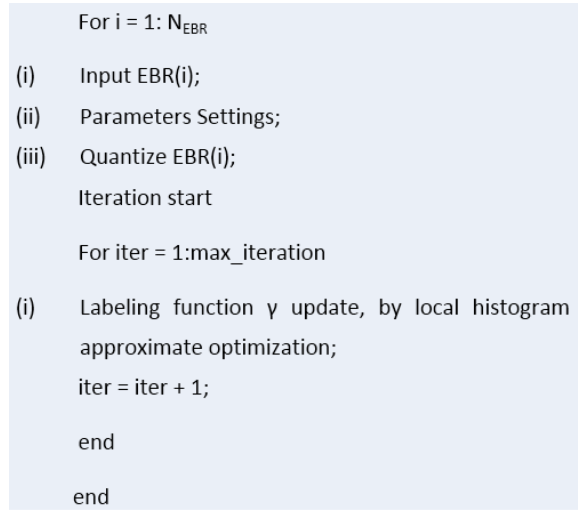
Figure 9. Main flow of LS-ORTSEG based EBR s segmentation.